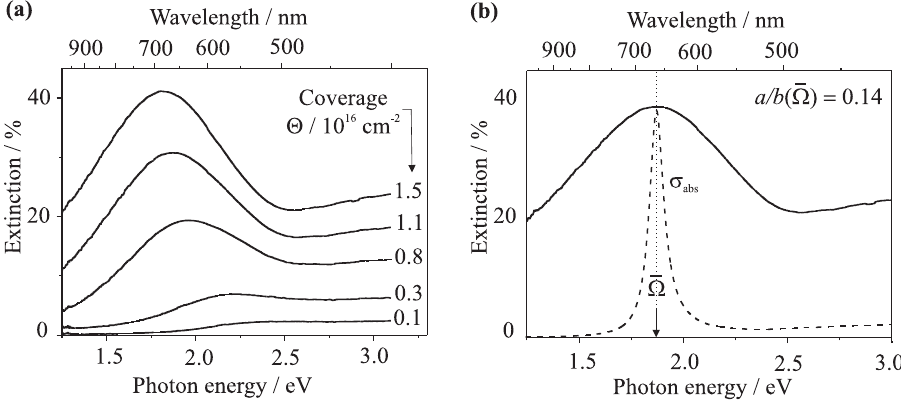
Figure 2. ( a ) Extinction spectra during growth of gold on sapphire at different coverage Θ ; ( b ) Optical extinction spectrum of gold particles 24 h after preparation (solid line) and calculated absorption cross section of a single particle with the same resonance frequency as the ensemble (dashed